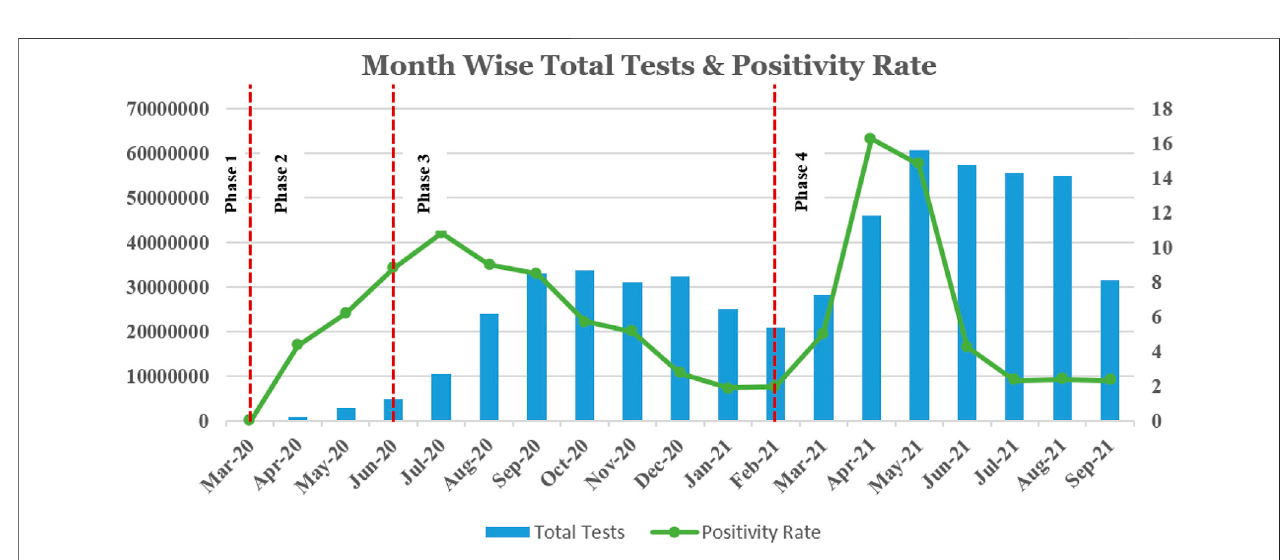
FIGURE 2 | Month-wise total tests and positivity rate in India.